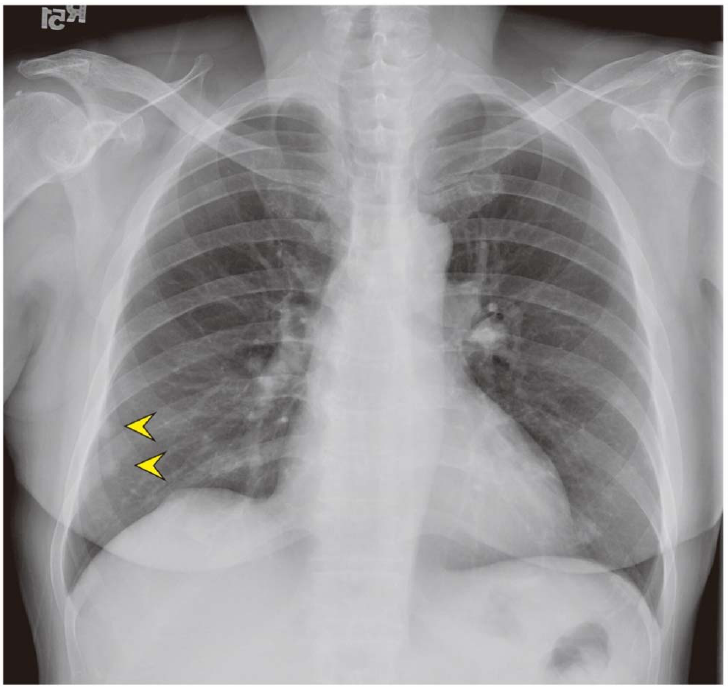
Figure 2. The chest X ‐ ray revealed two homogeneous pulmonary nodules at right lower lung field (arrow head).